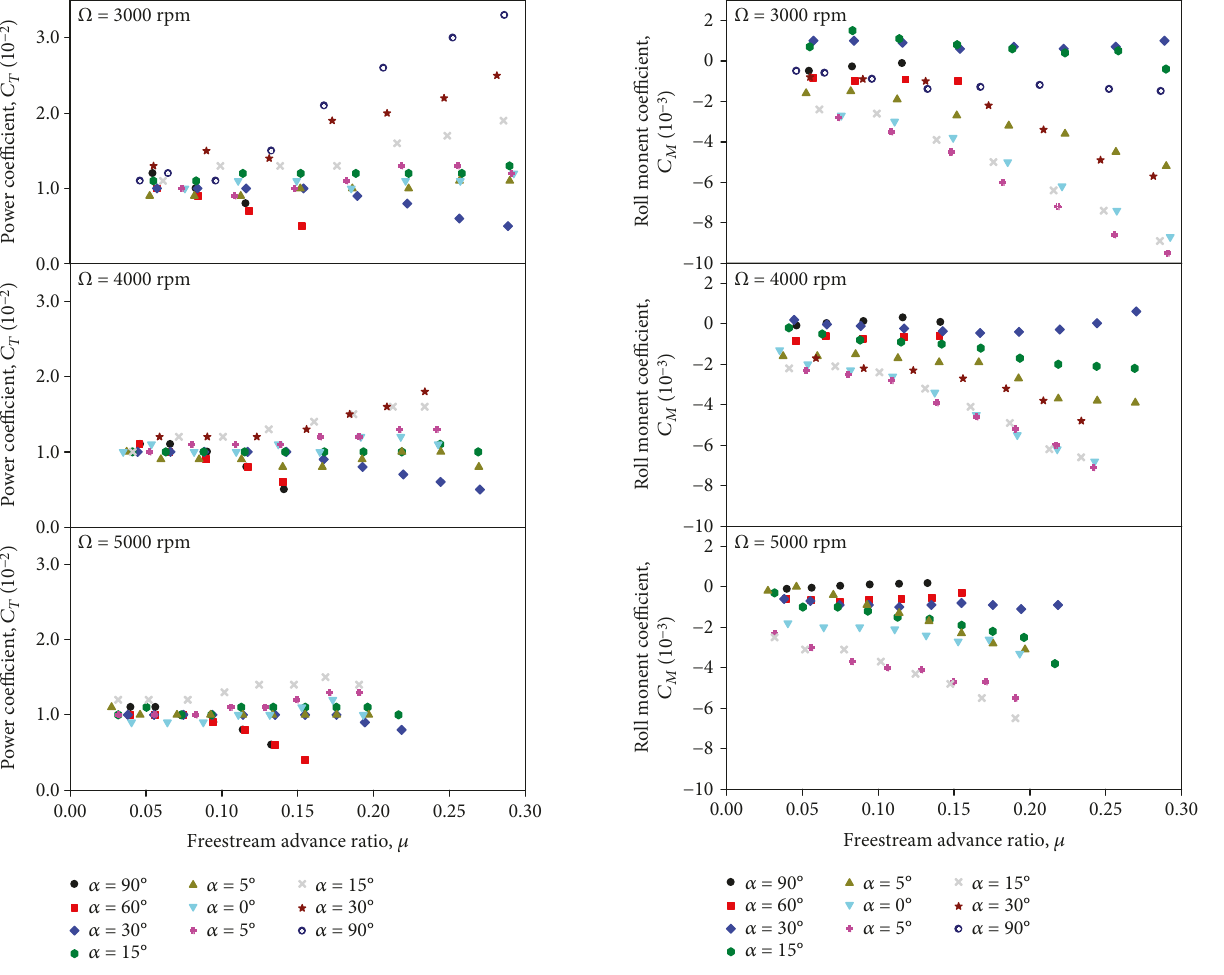
Figure 10: Power coe ffi cient for T-motor 18x6.1 at various uncorrected angles of attack under di ff erent rotational speeds.